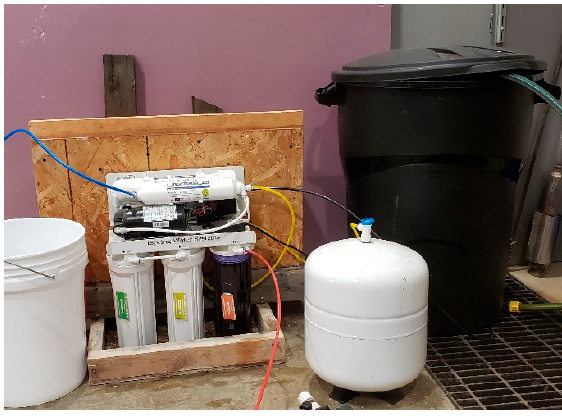
Figure 2. Reverse osmosis system used in this study.